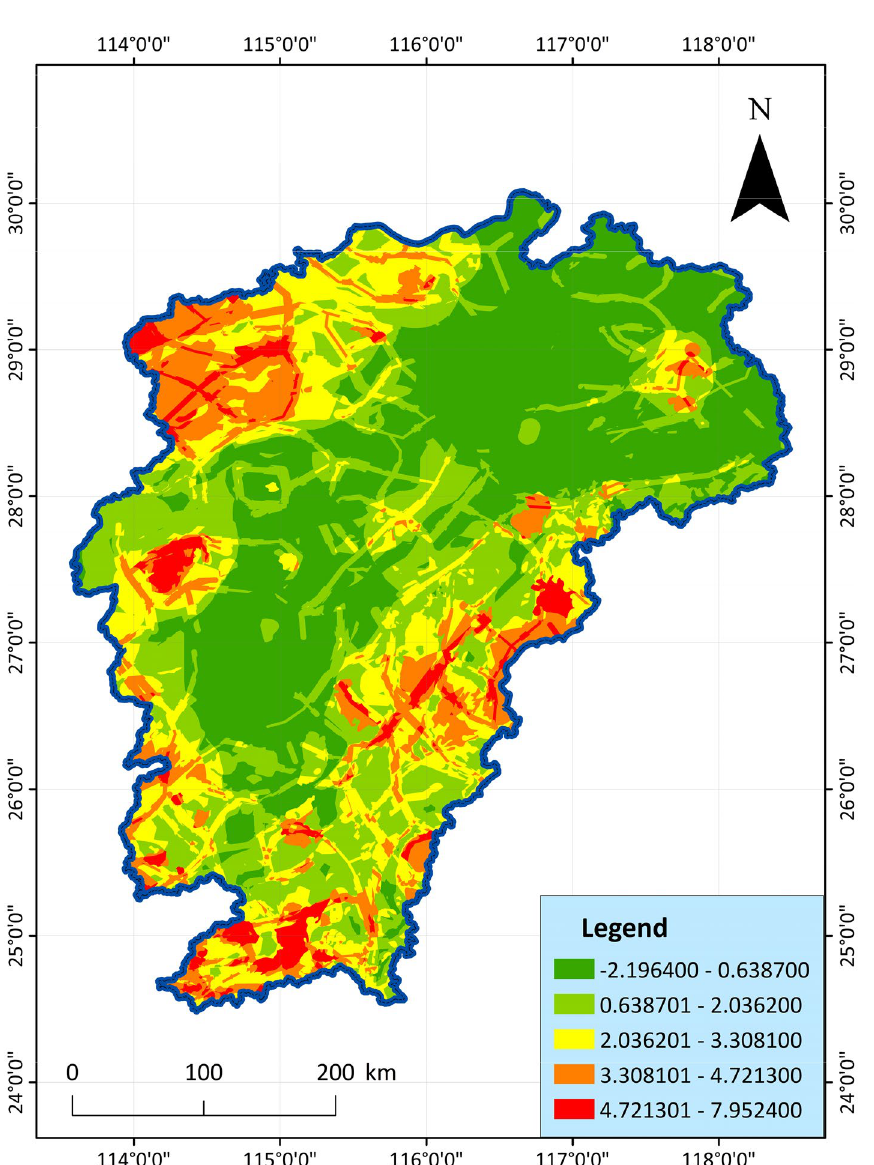
Figure 13. PCA geothermal resource potential evaluation diagram, showing the potential score for each